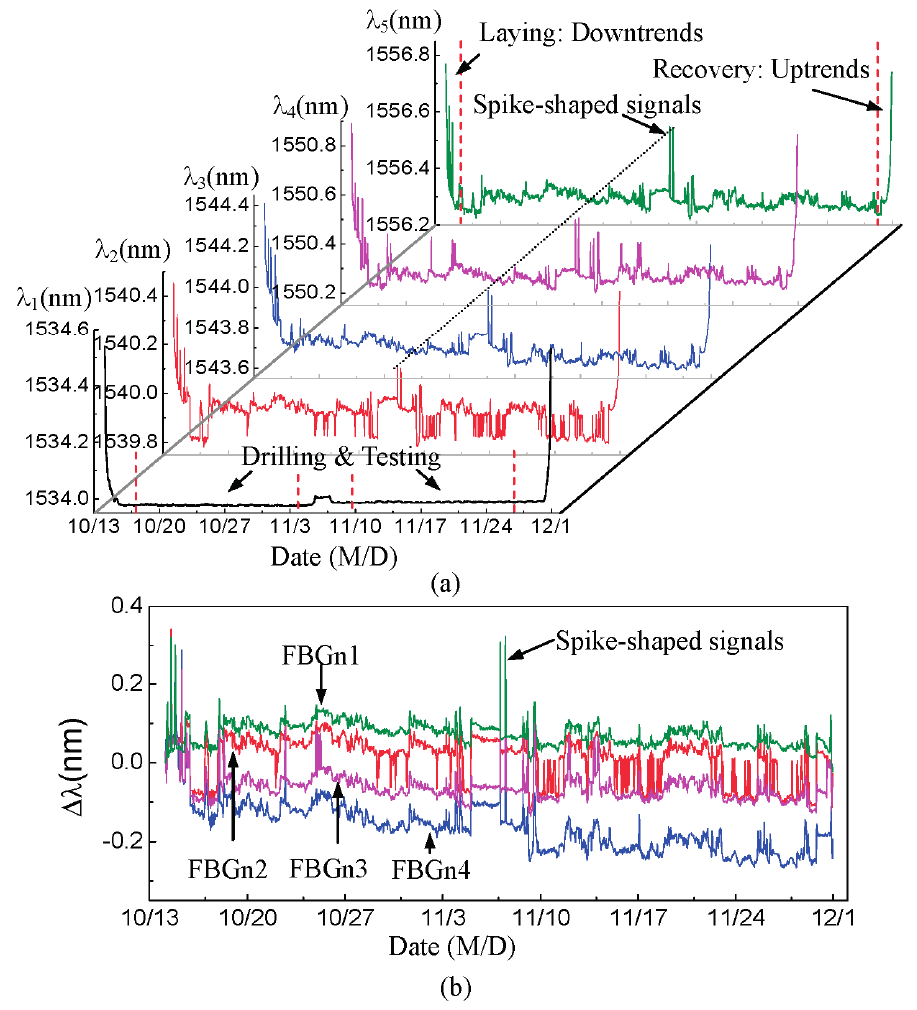
Figure 4. Marine test data of the riser stress monitoring sensor system. ( a ) Measured wavelengths of five FBG sensors; ( b ) compensated data of four FBG strain